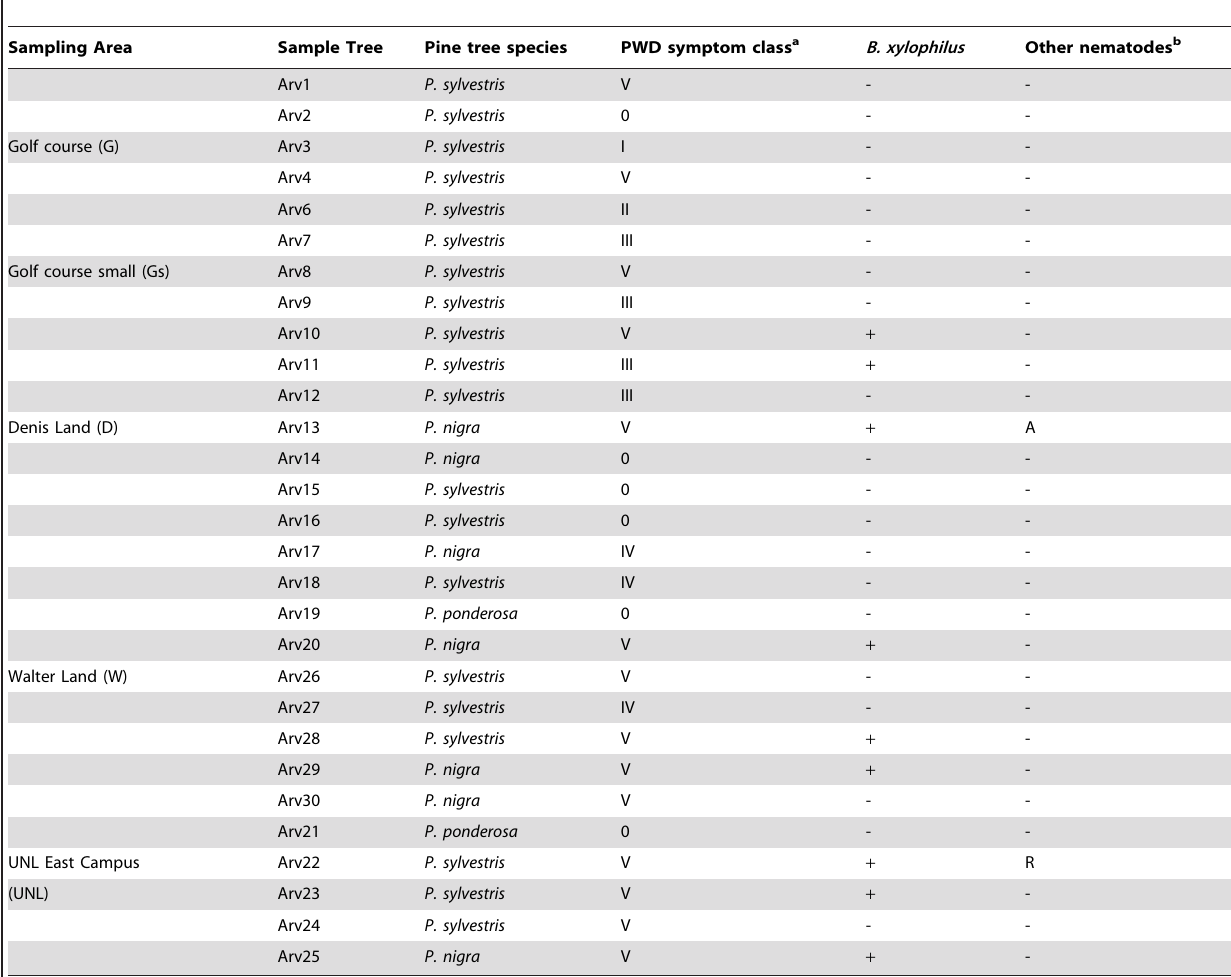
Table 1. Sampled Pinus spp. from different geographical areas and classified based on the PWD symptoms they expressed. + , presence of nematode; -, absence of